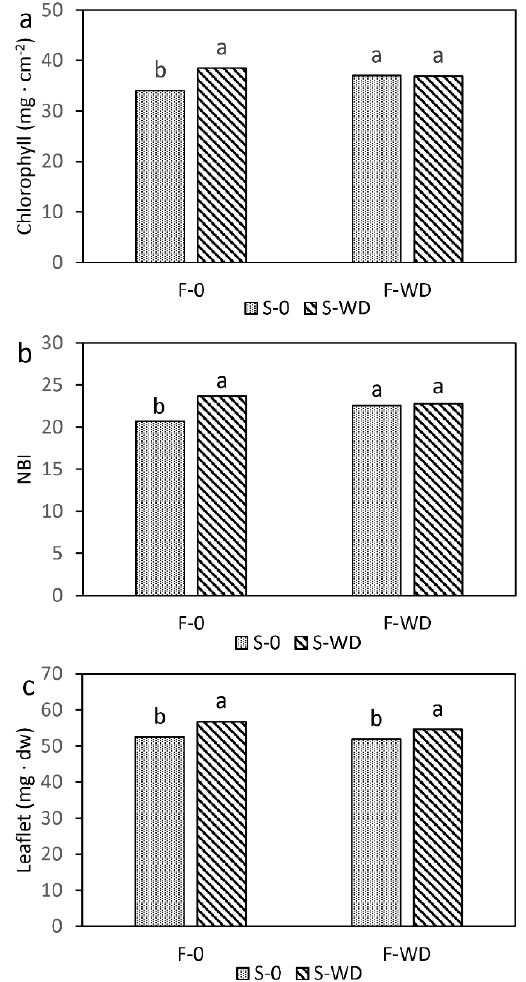
Figure 2. Chlorophyll concentration ( a ); nitrogen balance index, NBI ( b ); and biomass of field bean leaflets ( c ), as affected by the interaction of wood distillate (WD) distribution as foliar spray (F) or soil irrigation (S). Data are means of 20 replicates. For each parameter, columns with the same letter indicate not significantly different means at p ≤ 0.05, Tukey test.